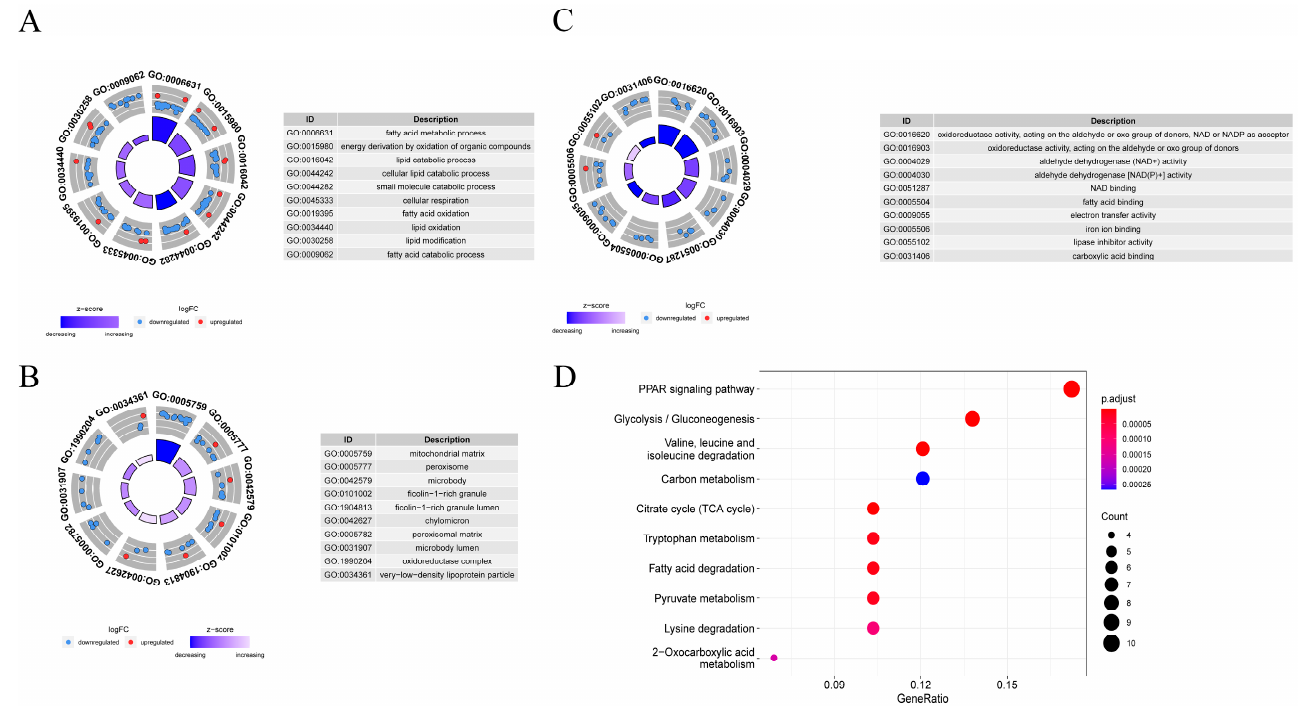
Figure 4. Functional enrichment analysis. ( A – C ) Gene Ontology (GO) enrichment analysis, including biological process (BP), cell composition (CC) and molecular function (MF). ( D ) Kyoto Encyclopedia of Genes and Genomes (KEGG) enrichment analysis.